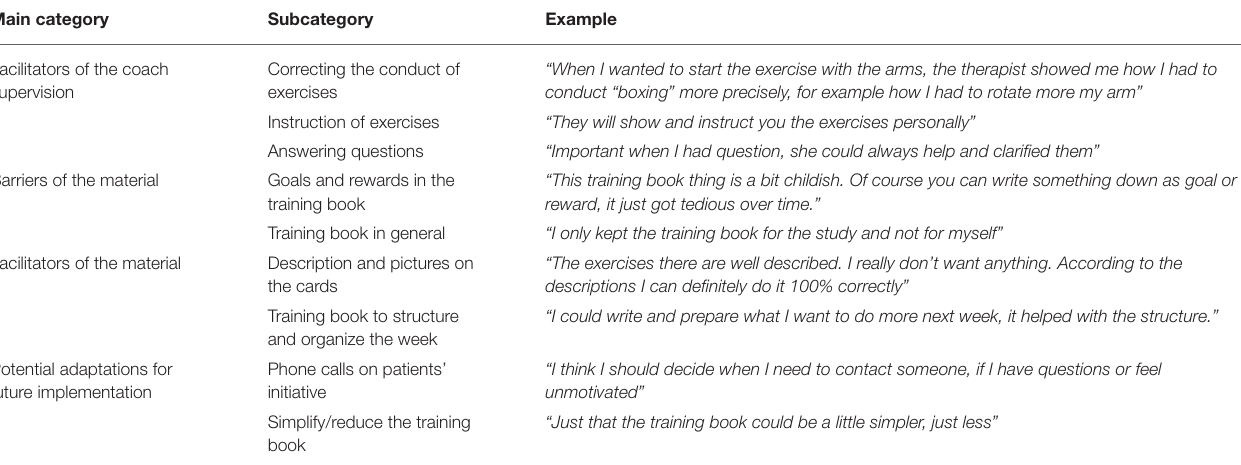
TABLE 5 | Results from interviews of patients: Supervision by coach and training